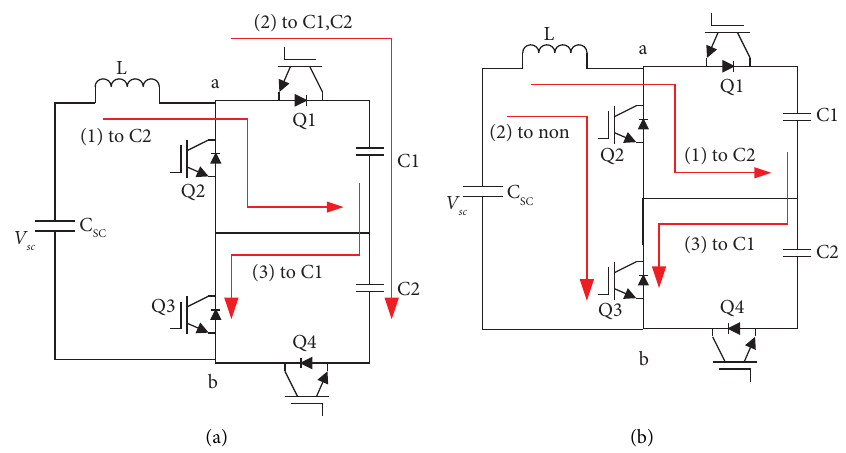
Figure 6: Charging state of the three-level buck-boost converter. (a) 1 < k < 2; (b) k > 2.